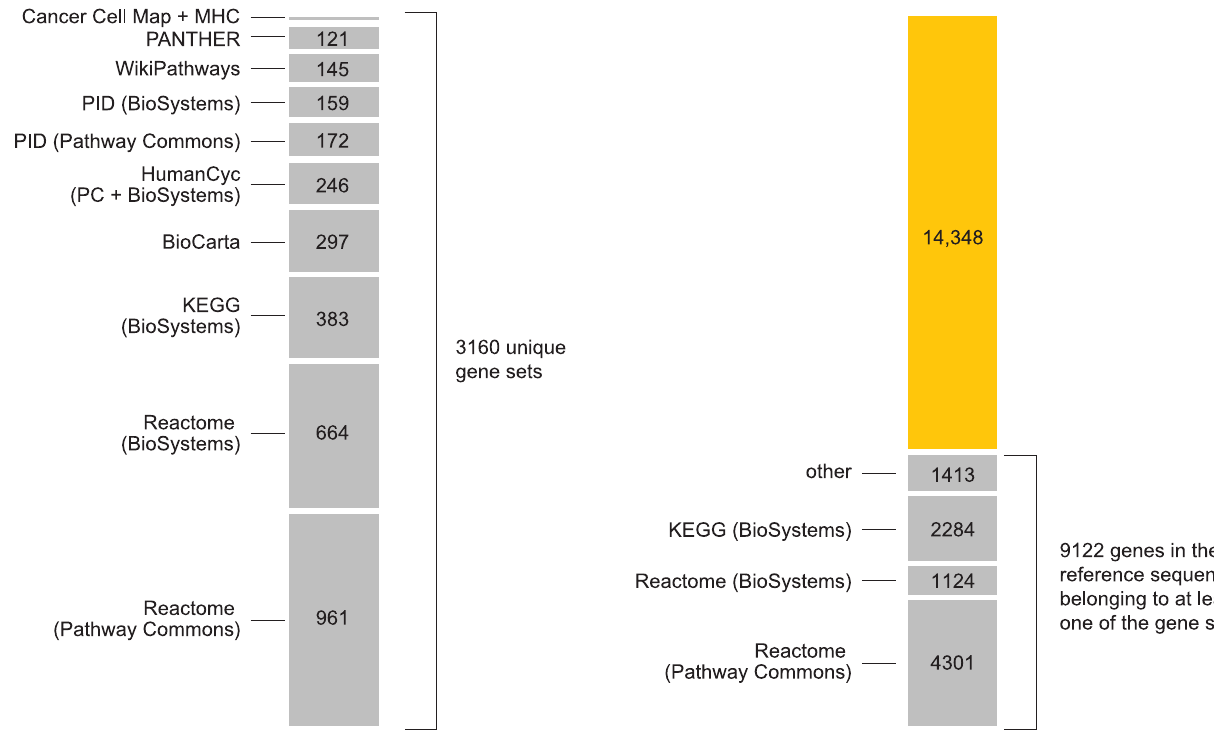
Figure 6. Summary of pathways used in the analysis. Chart on left shows number of unique gene sets obtained from the following pathway databases, included in this order: Reactome [167], Kyoto Encyclopedia of Genes and Genomes (KEGG) [146], BioCarta (www.biocarta.com), HumanCyc [147,168], NCI Nature Pathway Interaction Database (PID) [163], WikiPathways [169,170], PANTHER [171] and Cancer Cell Map (cancer.cellmap.org). The majority of these pathways are retrieved from the Pathway Commons (PC) [165] and NCBI BioSystems [164] repositories. We include gene sets from both repositories when gene sets from same pathway differ (see Supplementary Materials). We include two additional gene sets for ‘‘classical’’ and ‘‘extended’’ MHC [90,91]. Right-hand chart shows gains in gene coverage by including additional databases in the analysis, where ‘‘gene coverage’’ is defined as any genes in reference sequence that are assigned to at least one pathway. From the total of 3160 gene sets (including MHC and 6 MHC), we achieve coverage of 39% of genes in reference sequence (see Figure S6).